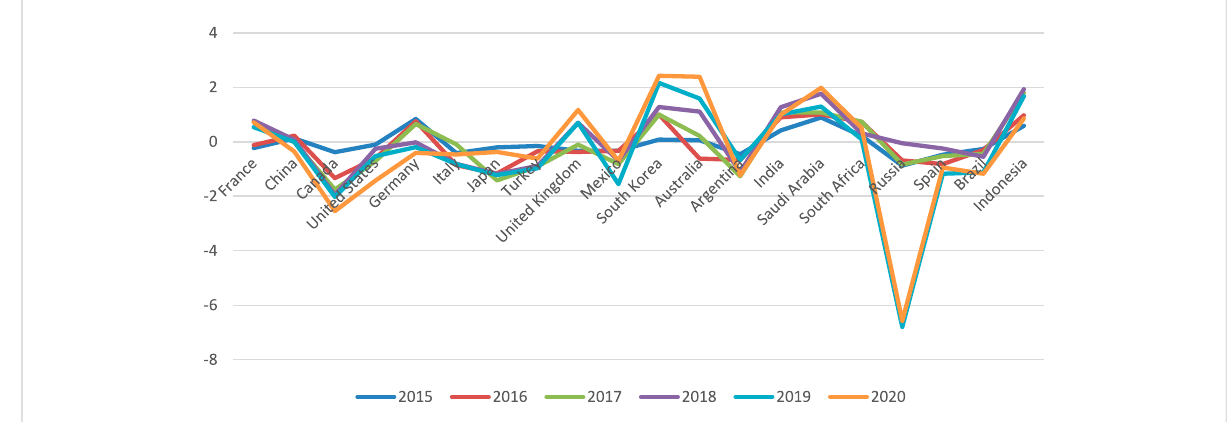
FIGURE 2 Input-out empirical nexus between study